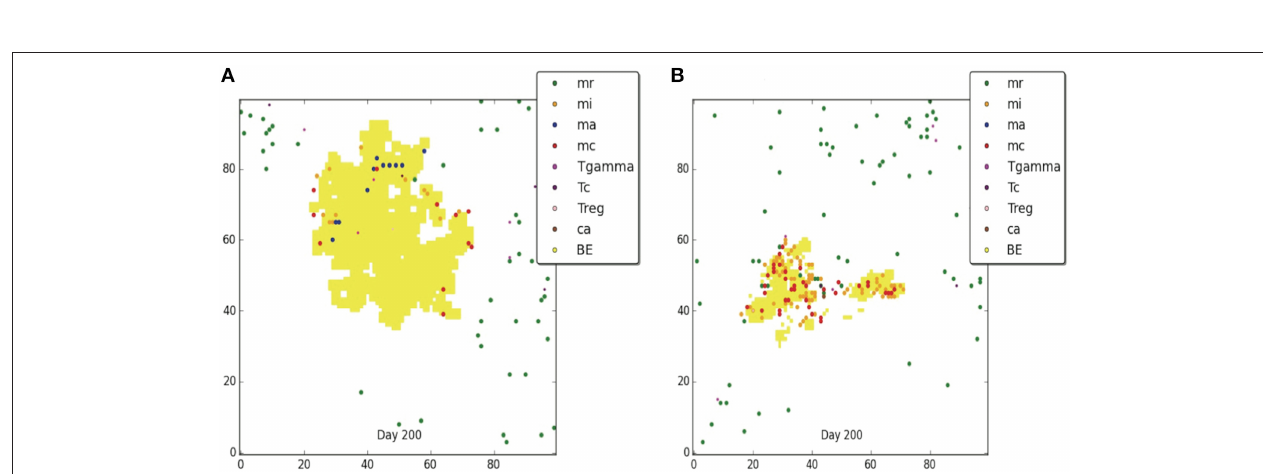
FIGURE 4 | Comparison of dissemination outcomes in the absence of TNF- α for ABM-ST (A) and ABM-PHYS (B). See Appendix 4 in Supplementary Material for relevant parameters.